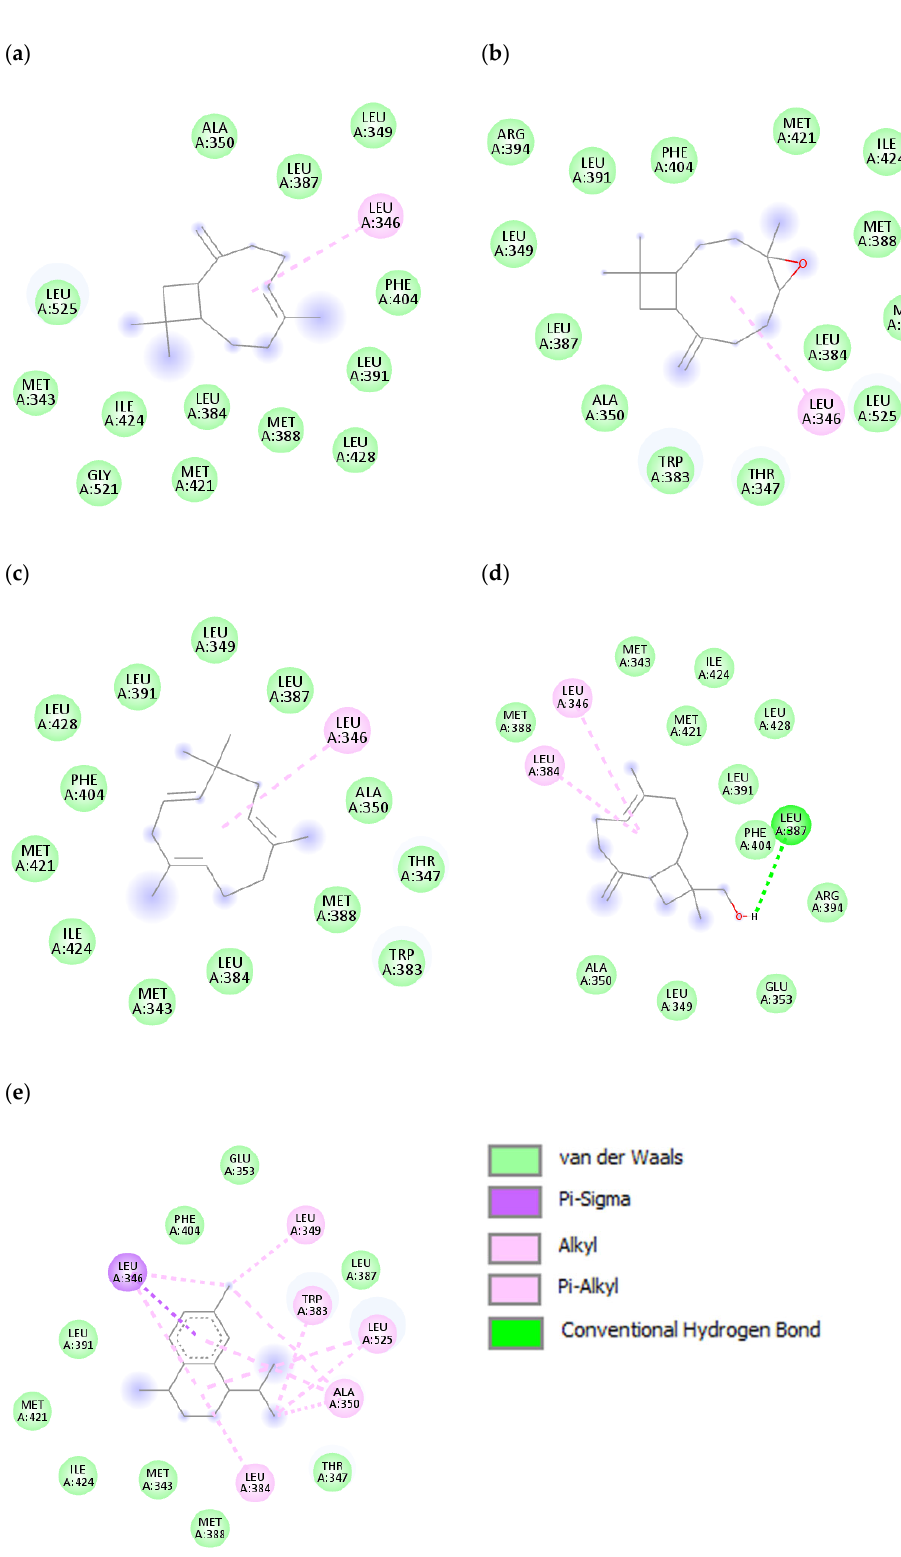
Figure 6. Interactions between the protein molecule and ligands shown in a 2D representation. Interacting atoms as well as pocket atoms are shown ( a ) cryophyllene, ( b ) cryophyllene oxide, ( c ) humulene, ( d ) 14-hydroxy-9-epi-(E)-caryophyllene, and ( e ) calamenene. The legend for the interactions involved is given in the left lower box.